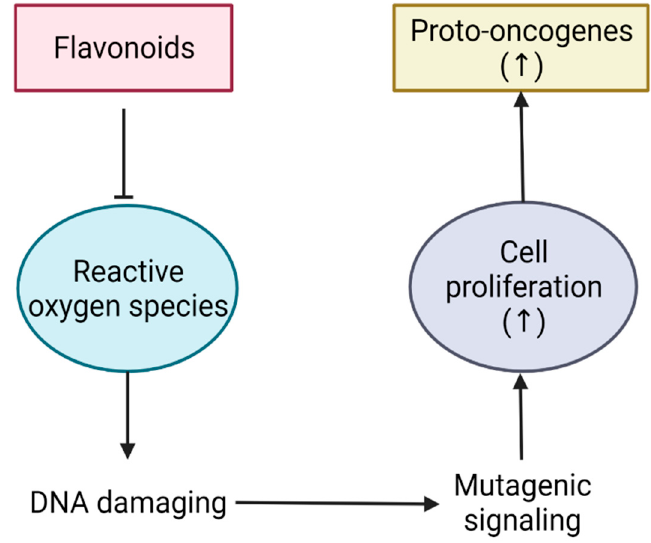
Figure 3. Scheme illustrating the flavonoid action on the reactive oxygen species (ROS) pathway.